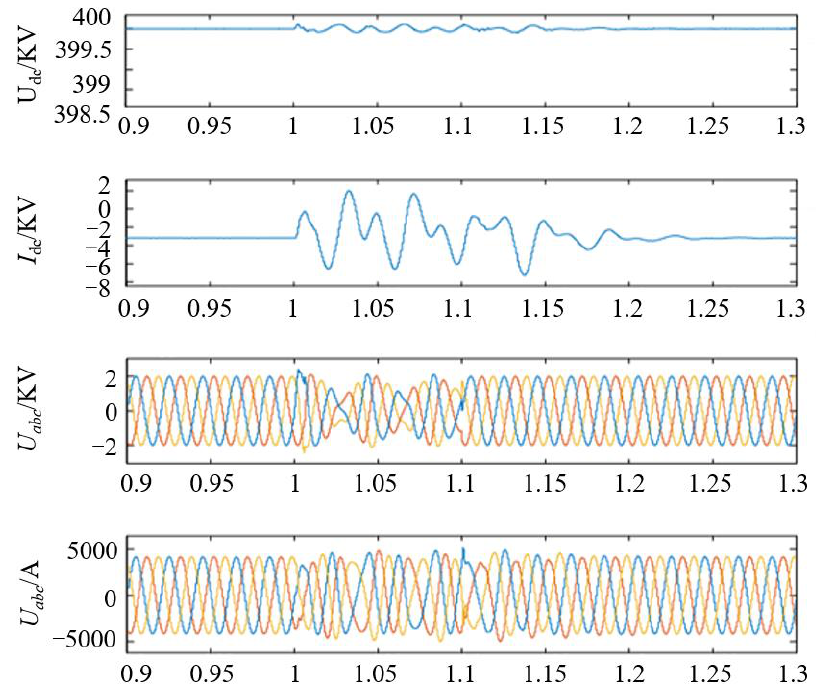
Figure 21. Simulation verification of low-frequency resonance suppression.